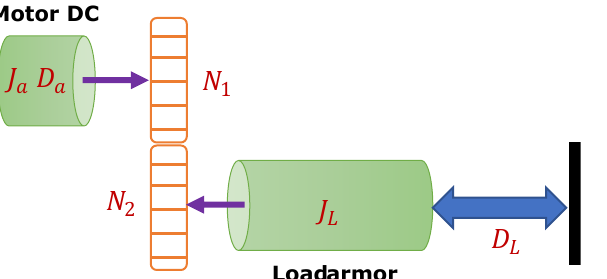
Figure 3. Relationship between rotational motor and linear displacement. The relation of N 1 and N 2 is considered to obtain the inertia relation J m = J a + J L ( N 1 ) 2 . Therefore, the relationship of the angular with the damping relation D m = D a + D L ( N 1 N 2 conversion with the linear displacement can be observed in Figure